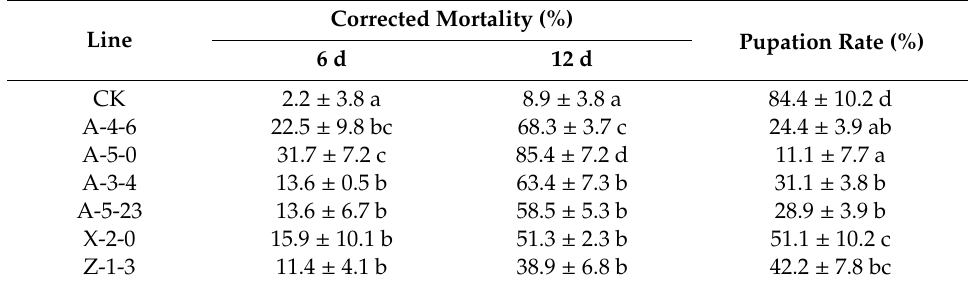
Table 2. Insecticidal activity of Bt transgenic poplar against Micromelalopha troglodyta . Corrected Mortality (%) Line Pupation Rate (%)